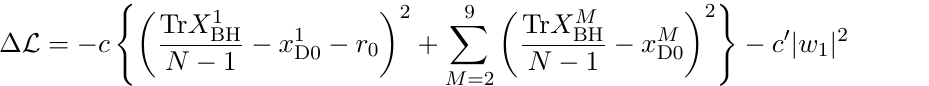
and r , the force acting trap bunch